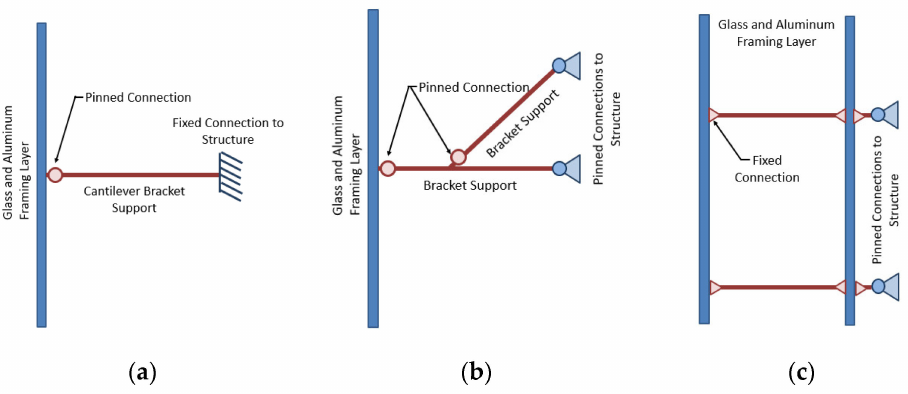
Figure 5. Support Mechanisms for DSF: ( a ) cantilever bracket; ( b ) suspended structure; ( c ) frame